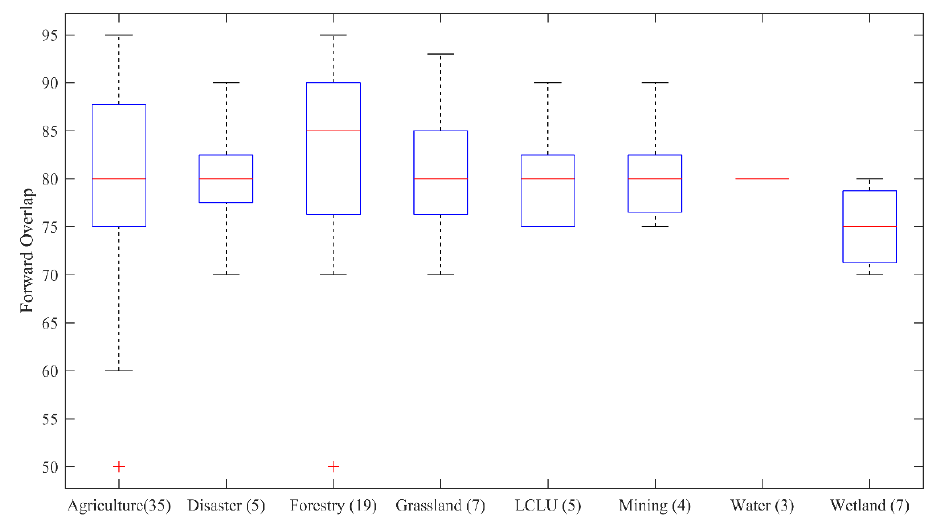
Figure 12. Forward overlap distribution of UAV imagery for different applications.